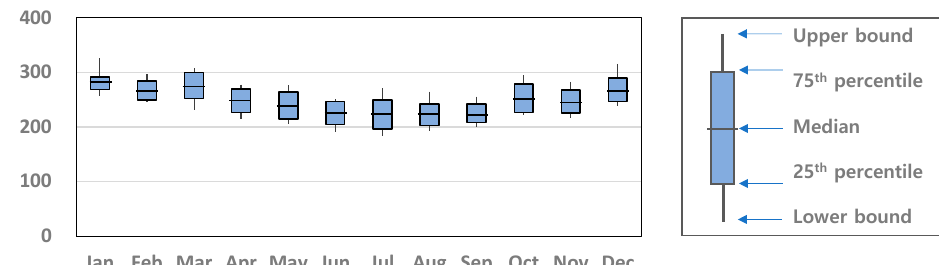
Figure 7. Monthly mortality rate per year, 2008–2018, for cerebrovascular disease for persons aged 65 or older in Seoul, Korea.